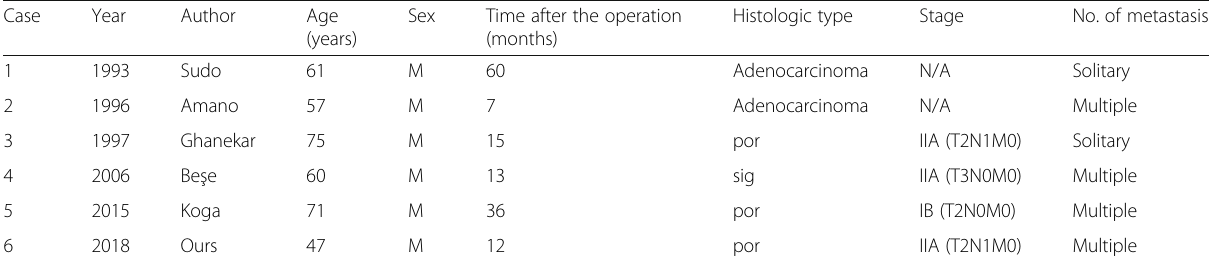
Table 1 Review of the six reported cases of metachronous skeletal muscle metastasis after curative gastrectomy Case